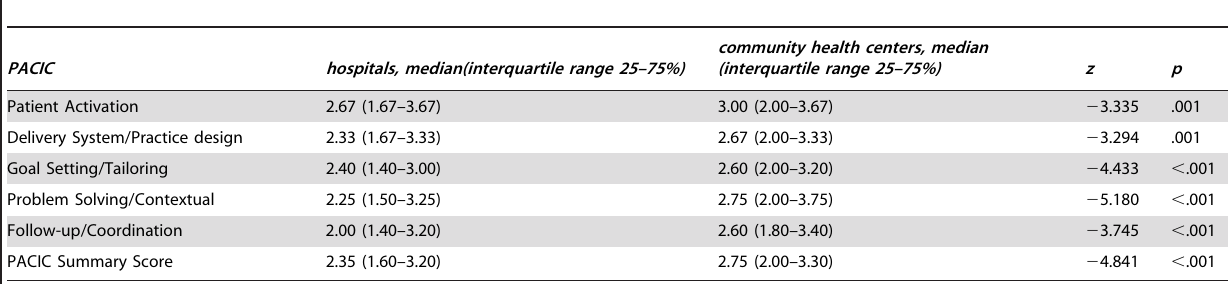
Table 4. The relationships between PACIC and the most often utilized medical institutions for monitoring and treating diabetes among the patients with type 2 diabetes (N